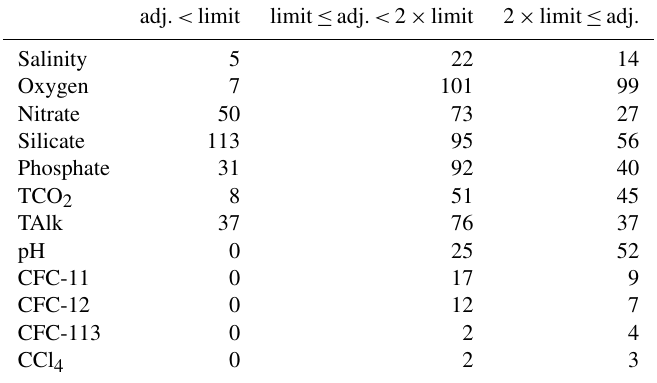
Table 7. Summary of the distribution of applied adjustments per variable, in number of adjustments applied for each variable. adj. < limit